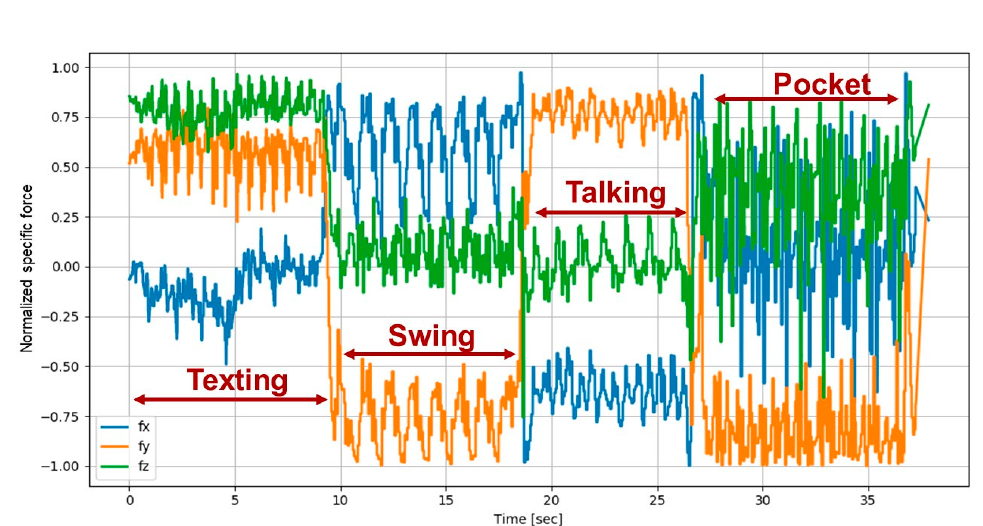
Figure 2. Normalized specific force vector as recorded during four smartphone locations: texting, swing, talking, and pocket.